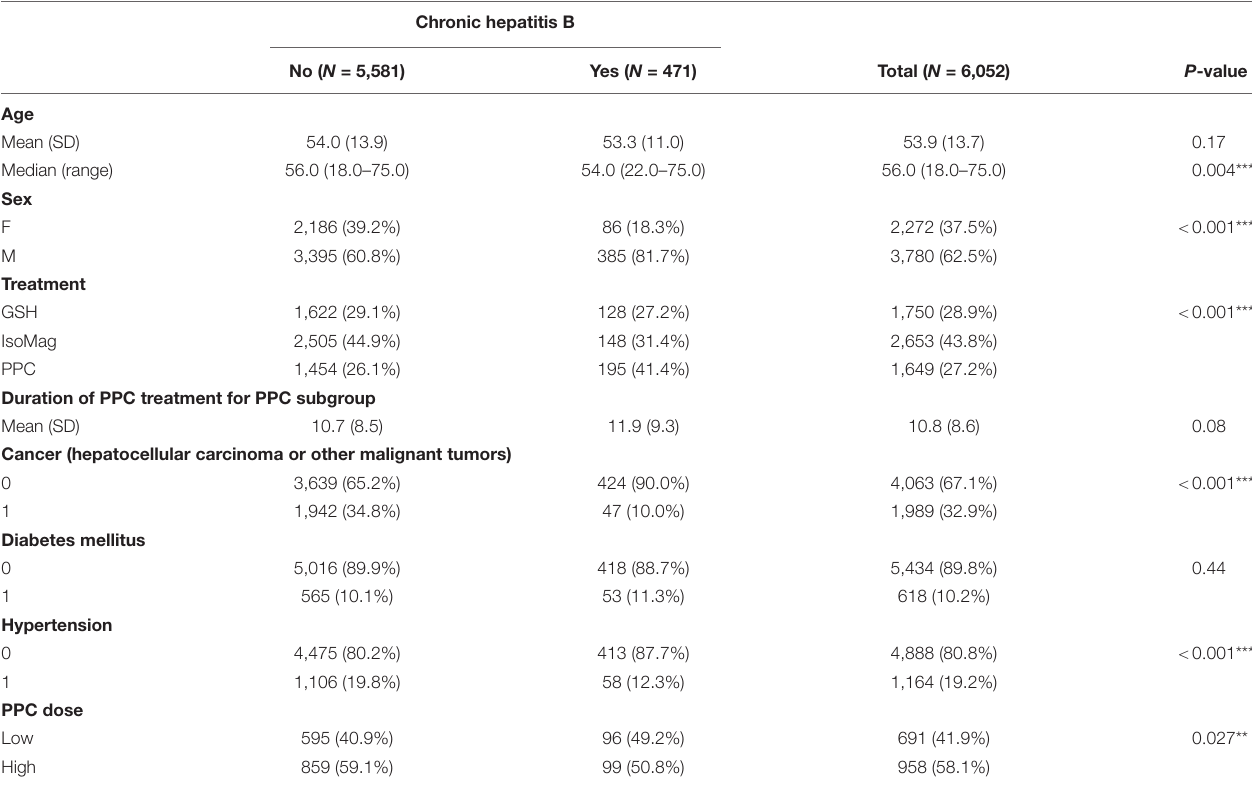
TABLE 1 | Patients characteristics by non-CHB or